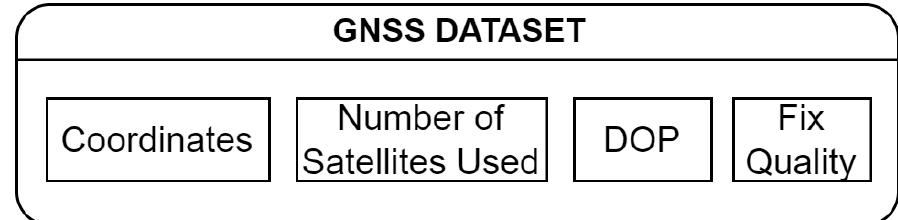
Figure 3. Block scheme of the position dataset.